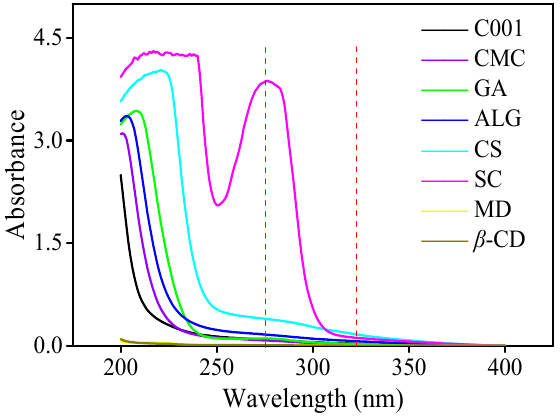
Figure 1. Ultraviolet (UV) absorption effect of wall material.